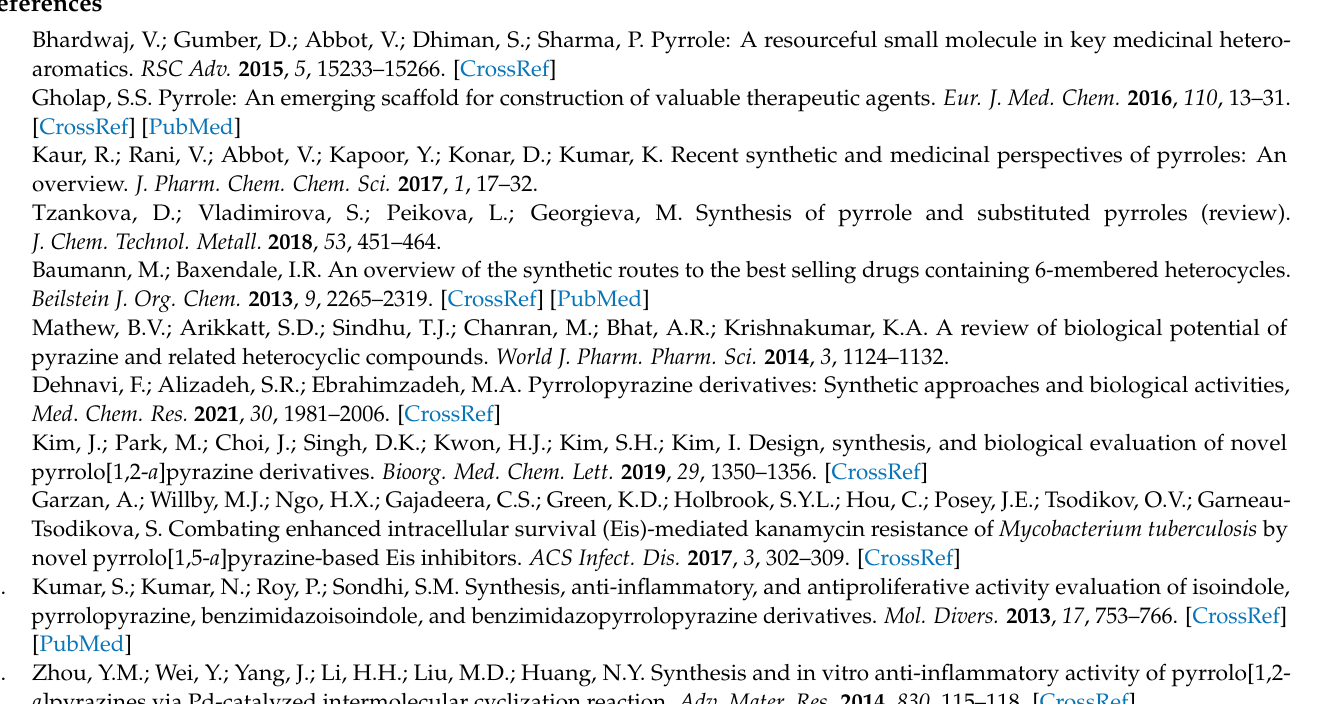
Figure S2. 13 C NMR spectrum of compound 2a , Figure S3. 2D NMR NOESY spectrum of compound 2a , Figure S4. 1 H NMR spectrum of compound 2b , Figure S5. 13 C NMR spectrum of compound 2b , Figure S6. 1 H NMR spectrum of compound 2c , Figure S7. 13 C NMR spectrum of compound 2c , Figure S8. 1 H NMR spectrum of compound 2d , Figure S9. 13 C NMR spectrum of compound 2d , Figure S10. 1 H NMR spectrum of compound 2e , Figure S11. 13 C NMR spectrum of compound 2e , Figure S12. 1 H NMR spectrum of compound 2f , Figure S13. 13 C NMR spectrum of compound 2f , Figure S14. 1 H NMR spectrum of compound 2g , Figure S15. 13 C NMR spectrum of compound 2g , Figure S16. 19 F NMR spectrum of compound 2g , Figure S17. 1 H NMR spectrum of compound 2h , Figure S18. 13 C NMR spectrum of compound 2h , Figure S19. 1 H NMR spectrum of compound 2i , Figure S20. 13 C NMR spectrum of compound 2i , Figure S21. 1 H NMR monitoring of the